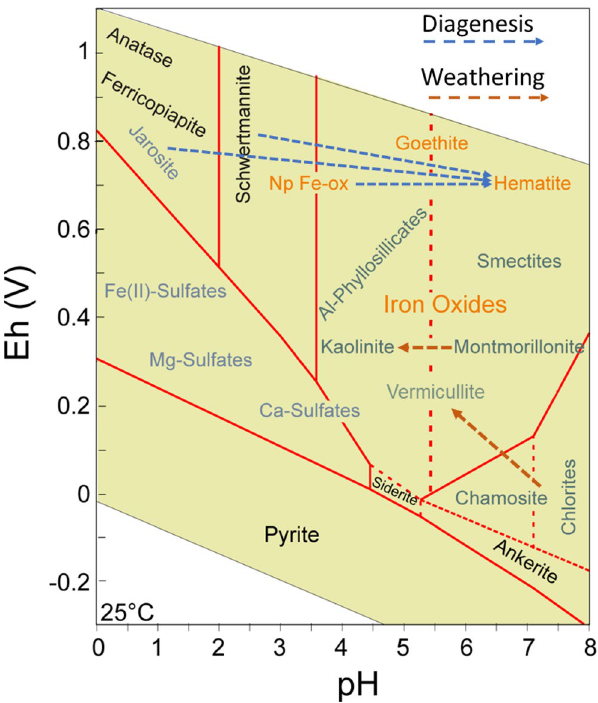
Figure 2. pH-Eh mineral stability diagram of different iron-bearing mineral phases and various clays. The blue arrows trace several diagenetic pathways starting in different Fe-bearing protoliths (e.g., sulfates and nanophase oxides), passing by an intermediate phase such as goethite (FeOOH), and ending in hematite (Fe 2 O 3 ). The diagram shows that mineral maturation toward iron oxides requires hydrolysis and dehydration, which are controlled by changes in pH and Eh. The red arrows trace weathering pathways in the clays forming sedimentary deposits at the surface and subsurface of Rio